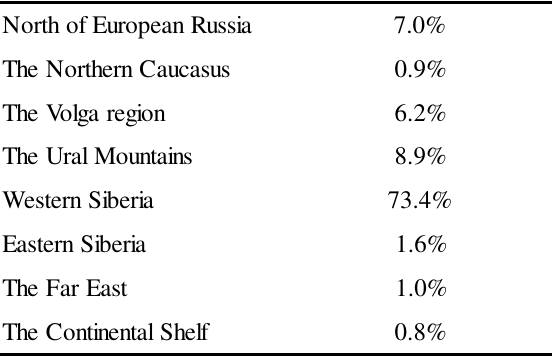
Table 2. The Location of Russia (cid:146) s Oil